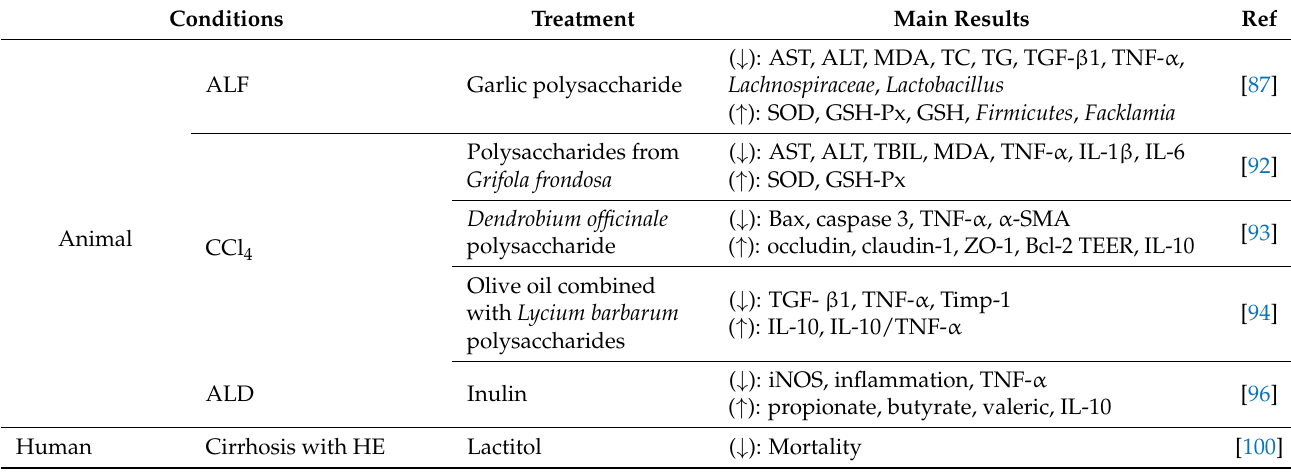
Table 3. Animal and human studies using